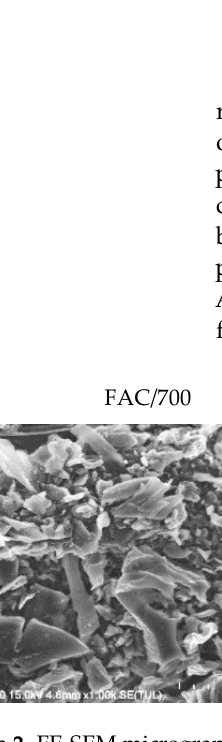
Figure 2. FE-SEM micrographs of the activated carbons derived from the common polypody leaves at activation temperatures of 700, 800, and 900 °C.